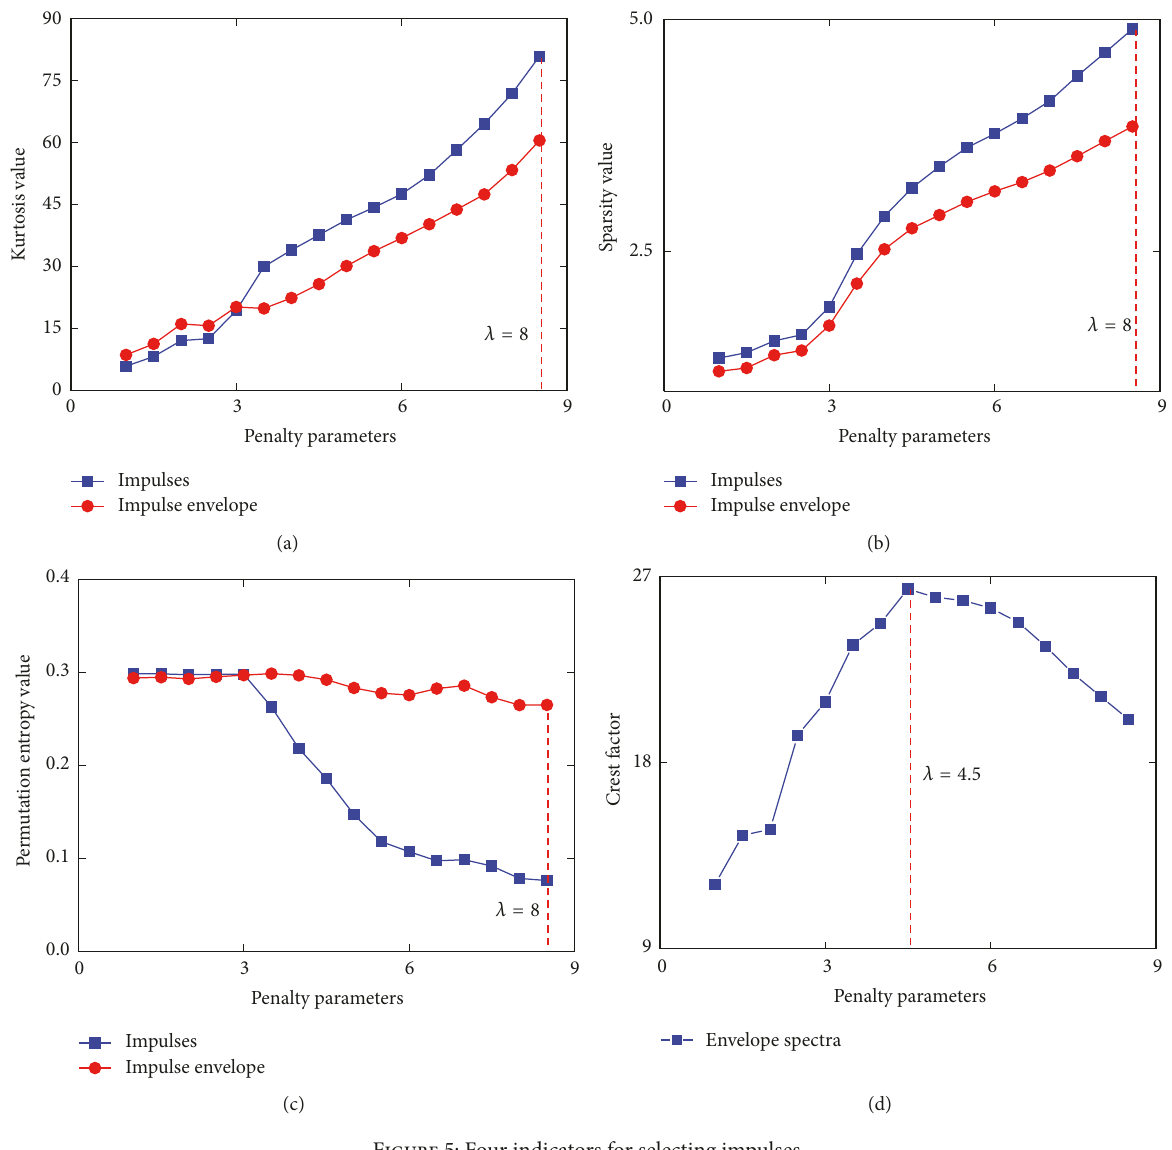
Figure 5: Four indicators for selecting